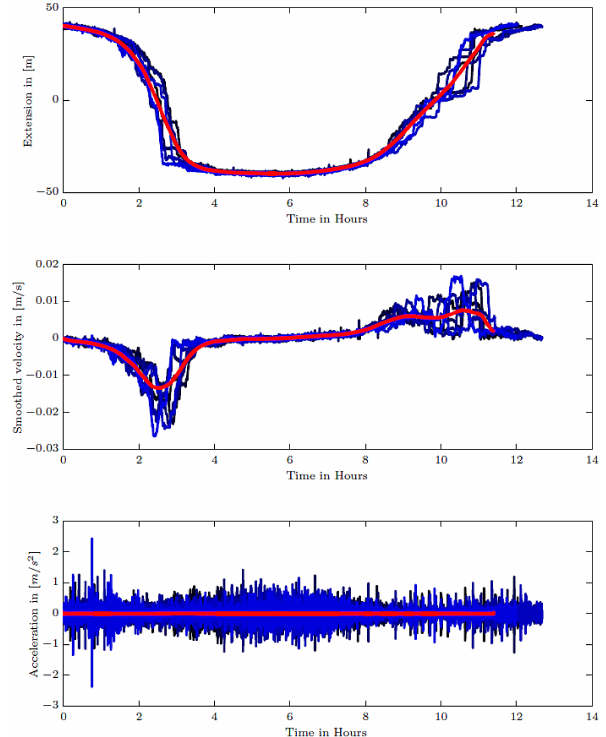
Figure 12. The three graphs show the position, smoothed velocity and acceleration of the buoy during six complete tidal cycles. The blue lines, varying from light to dark blue, indicate the succeeding tidal cycles. The red line is obtained by taking the smoothed average of all observed tracks. Position estimates are obtained here with the ground-truth solution of the Trimble R7 receiver (at